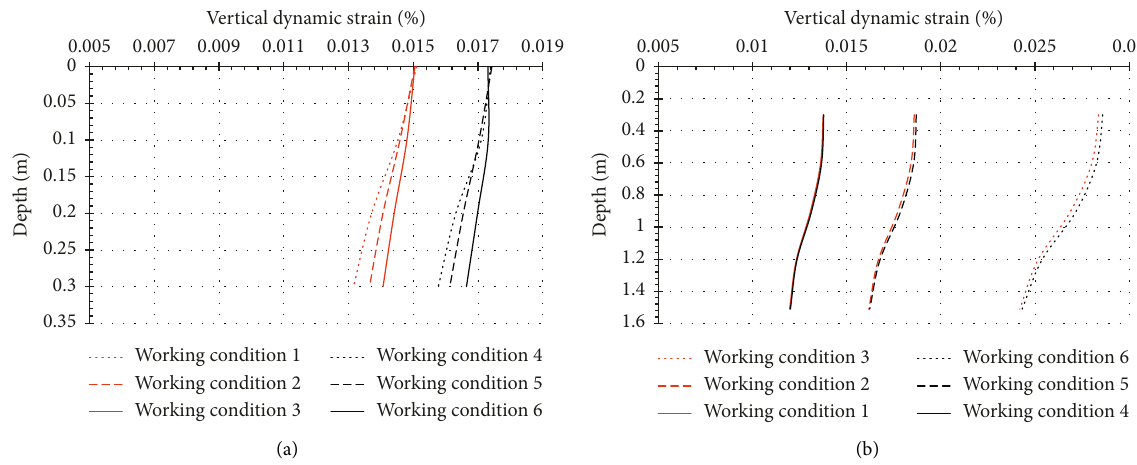
Figure 16: Strain distribution curve of the cross section of the foundation bed: (a) surface layer of the subgrade bed; (b) bottom of the subgrade bed.